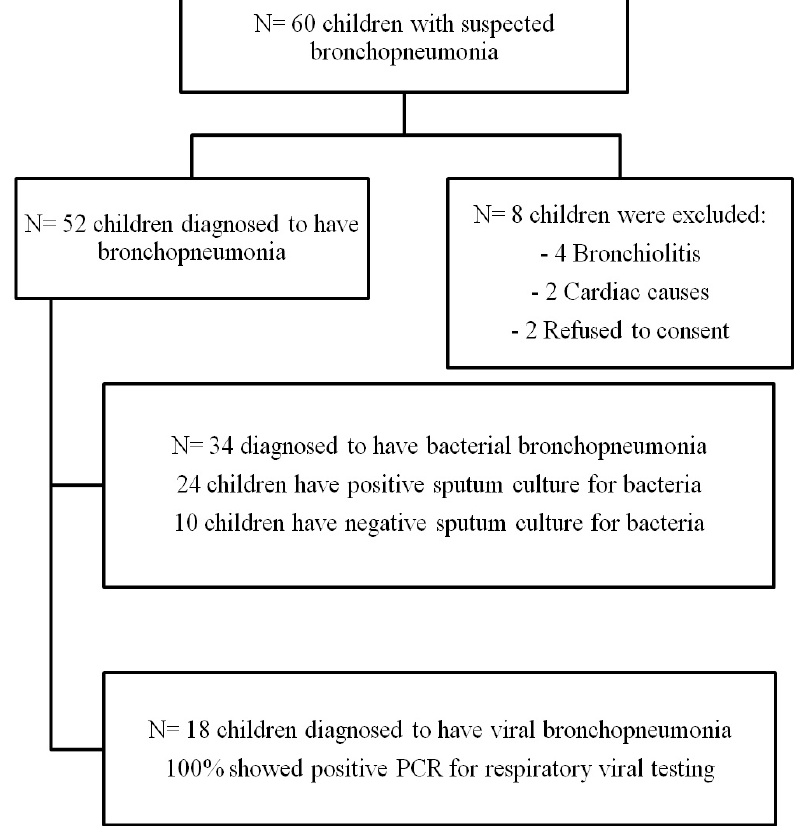
Figure 1. Patients flow chart.